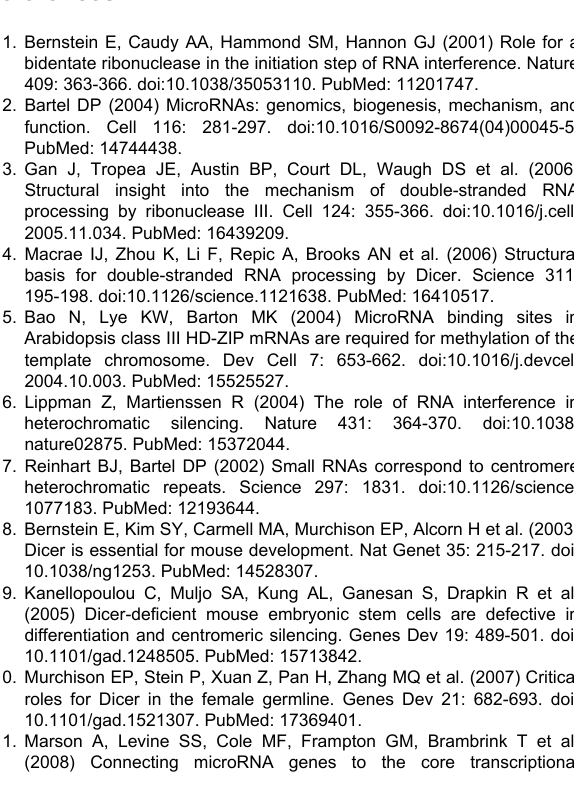
Table S1. List of primers used for qRT-PCR assays.